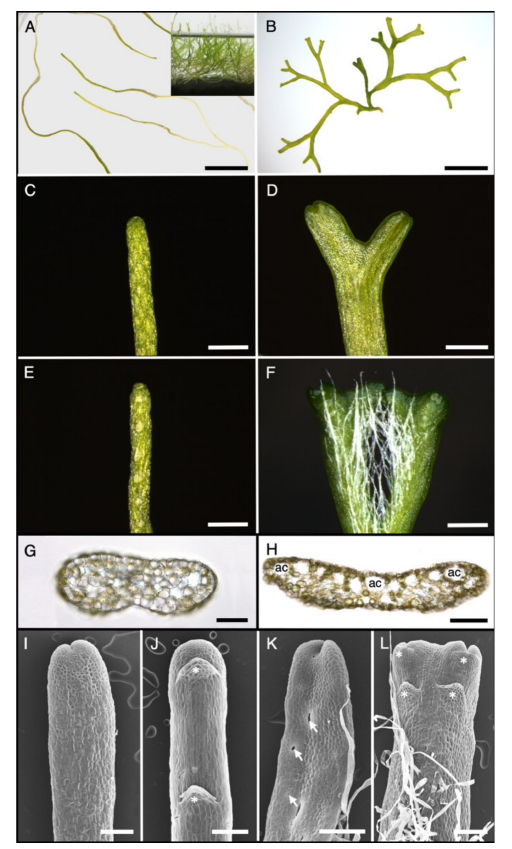
Figure 1. Land form (LF) and water form (WF) thallus morphologies of Riccia fluitans 001TC. ( A ) WF thalli were transferred to solid medium for image taking. Inset shows submersed growth of the WF.( B )LFthallus, grownonsolidmedium. ( C )WFand( D )LFdorsalthallusside. ( E ) WF ventralthallus side. ( F ) LF ventral thallus side revealing thallus branching and rhizoid formation. ( G ) WF thallus cross section lacking air chambers. ( H ) LF cross section revealing air chambers (ac). ( I – L ) SEM pictures of thallus tips. ( I ) Dorsal WF thallus side lacking air pores. ( J ) Ventral WF side develops ventral scales (white asterisks) but no rhizoids. ( K ) Dorsal LF thallus side with air pores. Three air pores are indicated by white arrows. ( L ) Ventral LF thallus side forming rhizoids and ventral scales (white asterisks). Scale bars A,B: 5 mm; C–F: 500 µ m; G–L: 200 µ